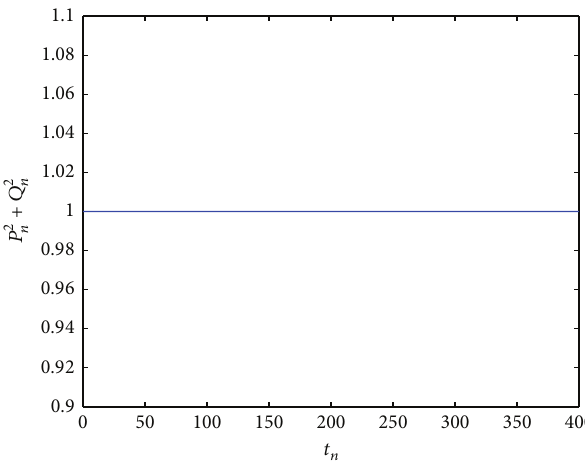
Figure 1: The exact solution of (23) simulated by (25) with fixed step size ℎ = 2 −8 .